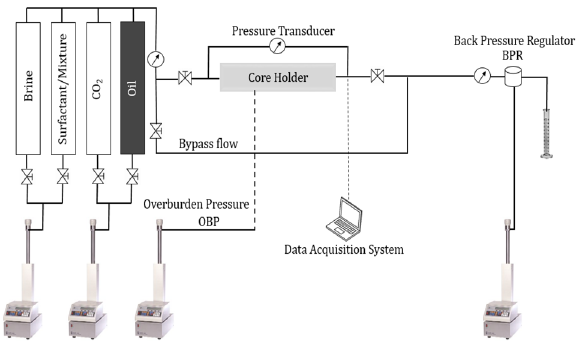
Fig. 1 Experimental setup